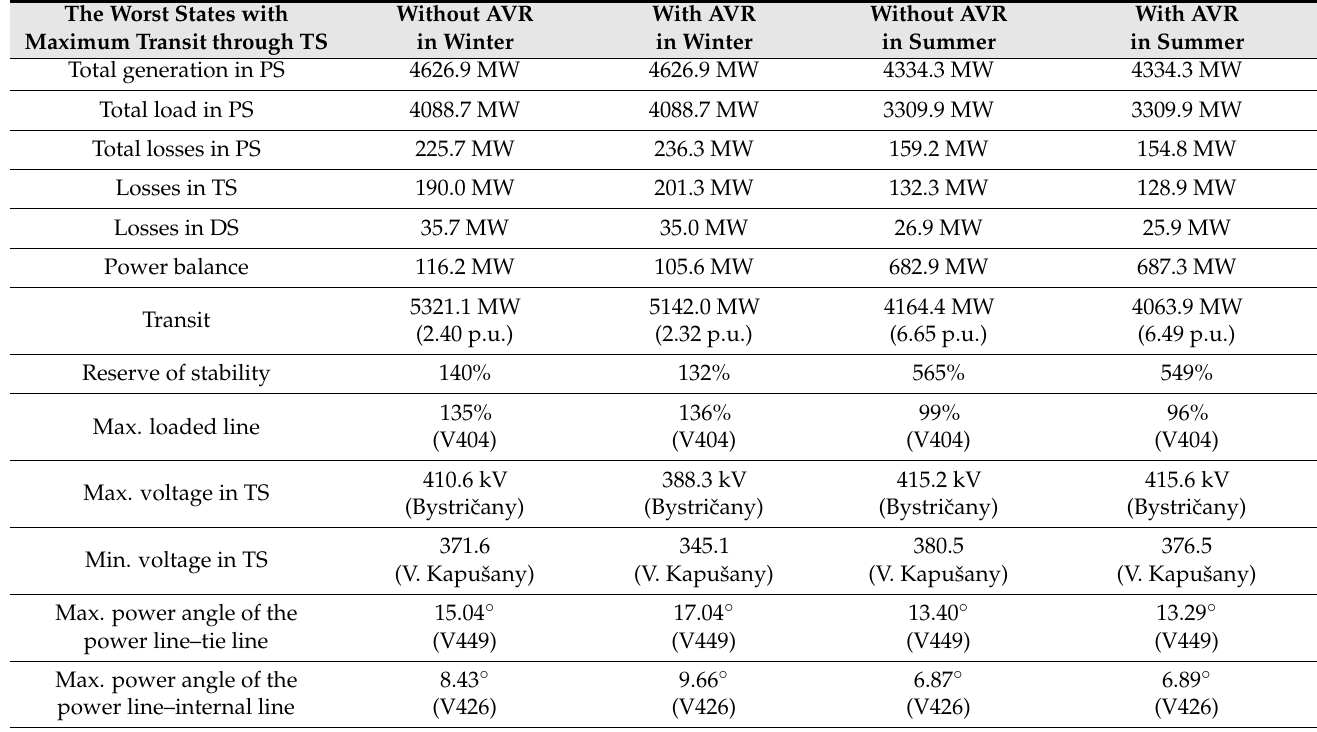
Figure 3. Overview of 400/110 kV transformer loads: winter (left), summer (right). Table 4. Load flow results: worst cases with maximum transit through the